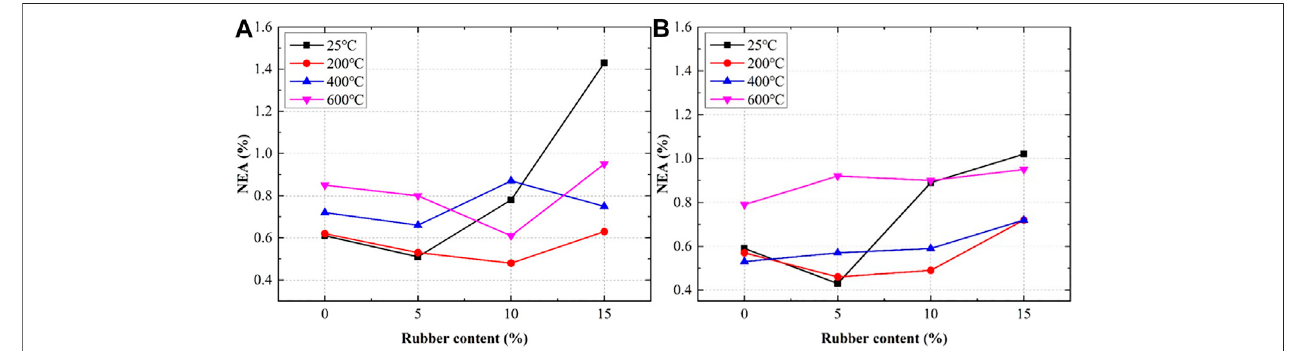
FIGURE 13 | Effect of rubber content on the NEA of (A) RRAC-A and (B) RRAC-B.